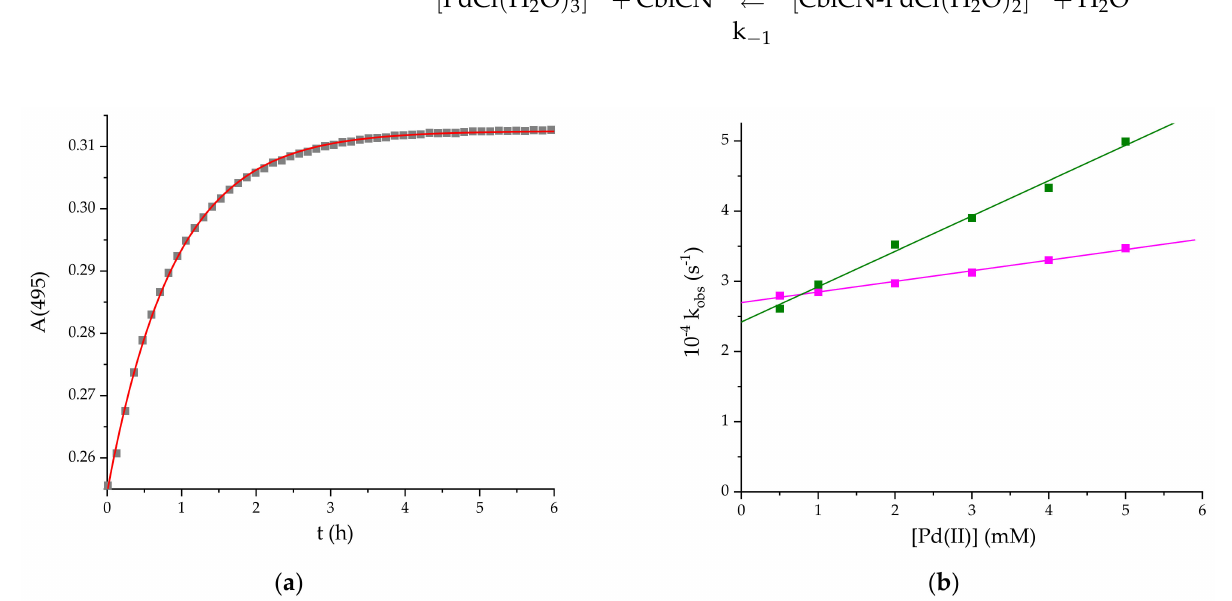
Figure 4. ( a ) The kinetic trace at 495 nm for the reaction of [PdCl(H 2 O) 3+ ] and [CblCN] (10:1) and ( b ) the dependence of k obs on Pd(II) concentration for the formation of 1 (pink) and 2 (green). pH = 2, 25 ◦ C, [CblCN] = 10 − 4